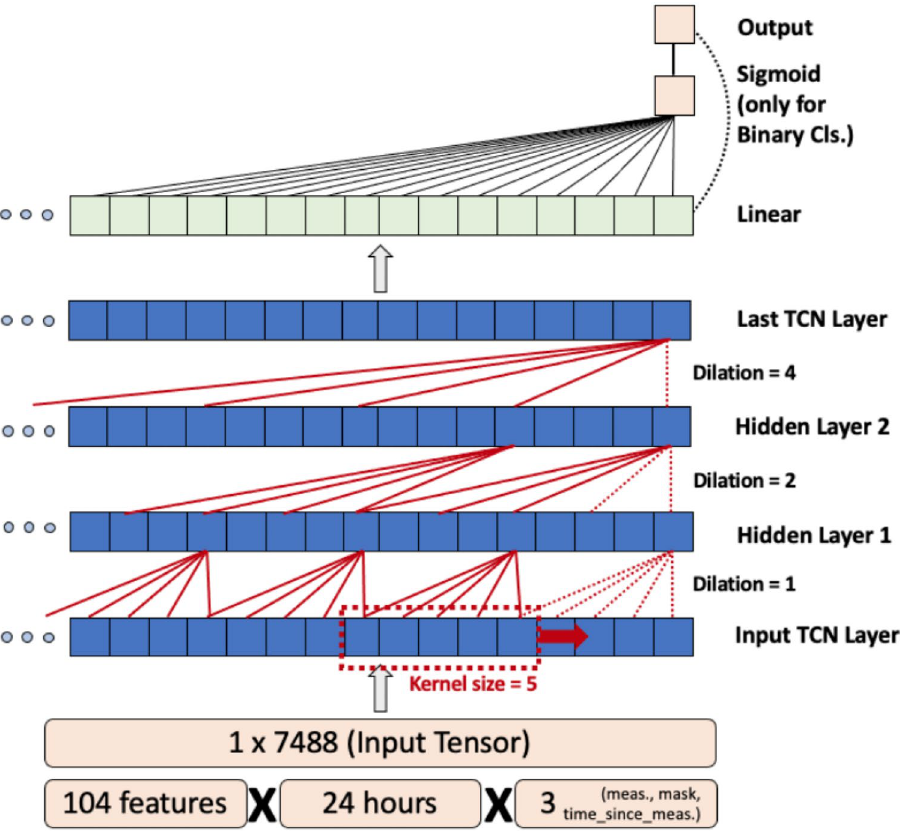
Figure 1. The temporal convolutional network (TCN) demonstrates a flexible input size due to its hierarchical architecture and exponential convolution dilation